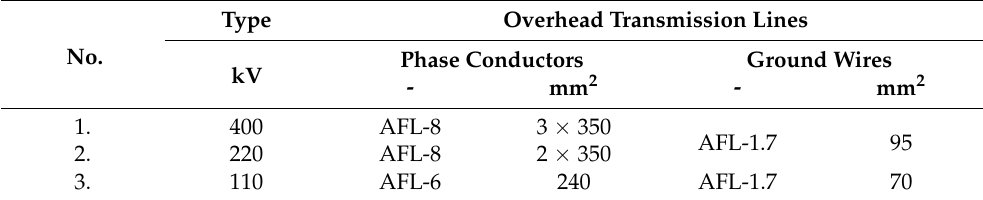
Table 4. Parameters of phase conductors and ground wires for a simple system of 440 kV, 220 kV and 110 kV